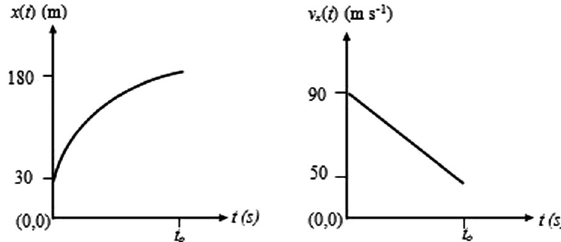
FIG. 26. Kinematics task with graphical format requesting quantitative solutions.